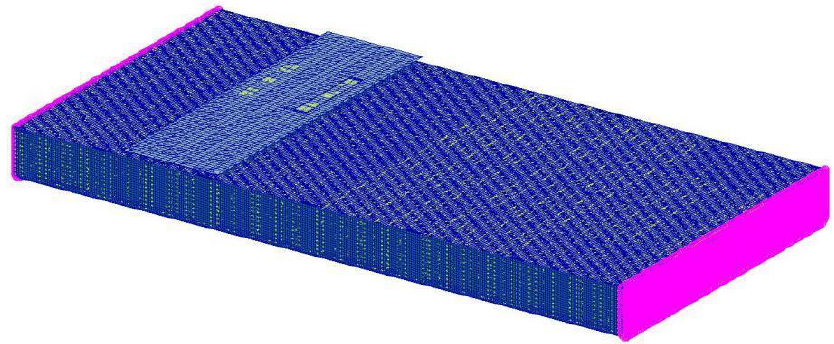
Figure 13. Model boundary conditions.